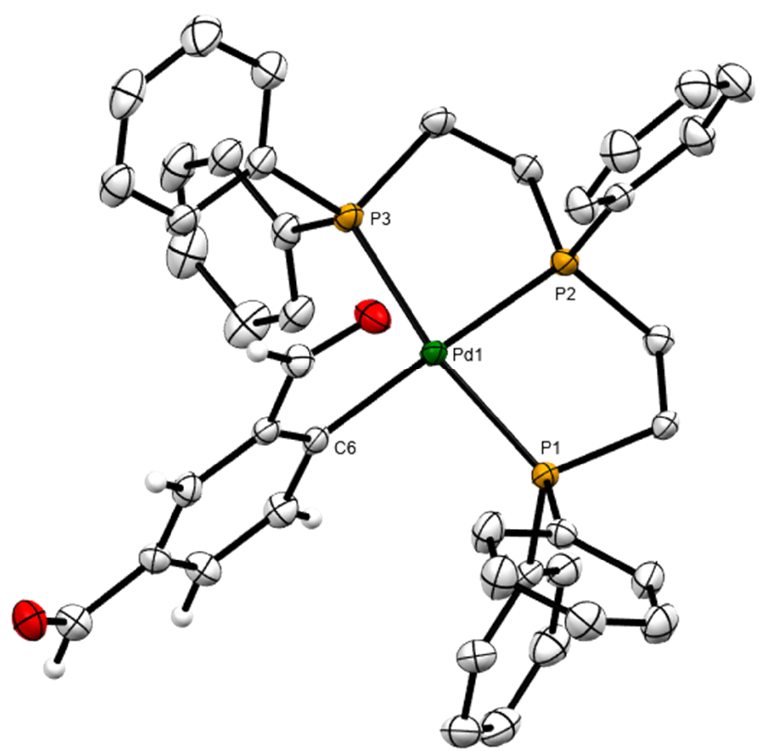
Figure 1. ORTEP drawing of complex 5b with thermal ellipsoid plot shown at 50% probability level. Hydrogen atoms and PF 6 counterions have been omitted for clarity. Selected bond distances (Å) and angles (˚) for 5b : Pd(1)-C(1) 2.080(3), Pd(1)-P(1) 2.3098(8), Pd(1)-P(2) 2.2762(8), Pd(1)-P(3) 2.3334(8), P(2)-Pd(1)-P(1) 83.97(3), P(2)-Pd(1)-P(3) 83.48(3) P(1)-Pd(1)-P(3) 163.65(3), C(1)-Pd(1)-P(3) 97.36(8), C(1)-Pd(1)-P(2) 176.84(9), C(1)-Pd(1)-P(1) C6 Pd1 P1 94.63(8). Selected crystallographic data: a ,